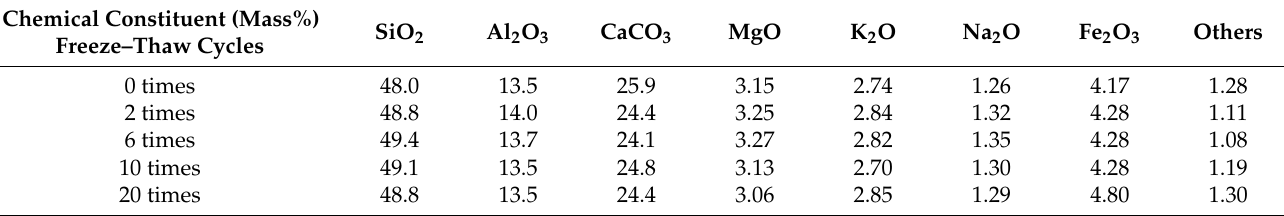
Table 3. Total elemental analysis of loess.